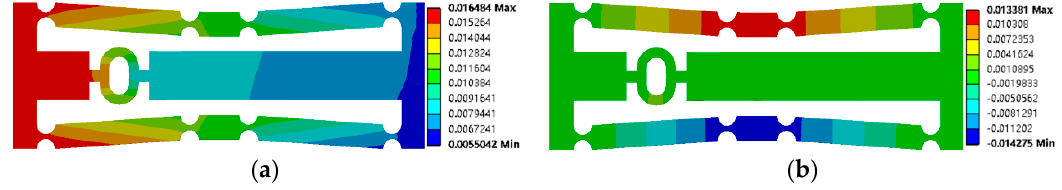
Figure 7. Dynamic simulation model. The sensor is mainly used to measure the axial strain, so the left end of the sensor is fixed and the sinusoidal force of 20 N is applied to the right end. The maximum displacement of Y direction on one side of spring is taken as output. Setting the frequency range to 0–10,000 Hz, a total of 100 equal points, the results of harmonic response analysis are shown in Figure. 8.